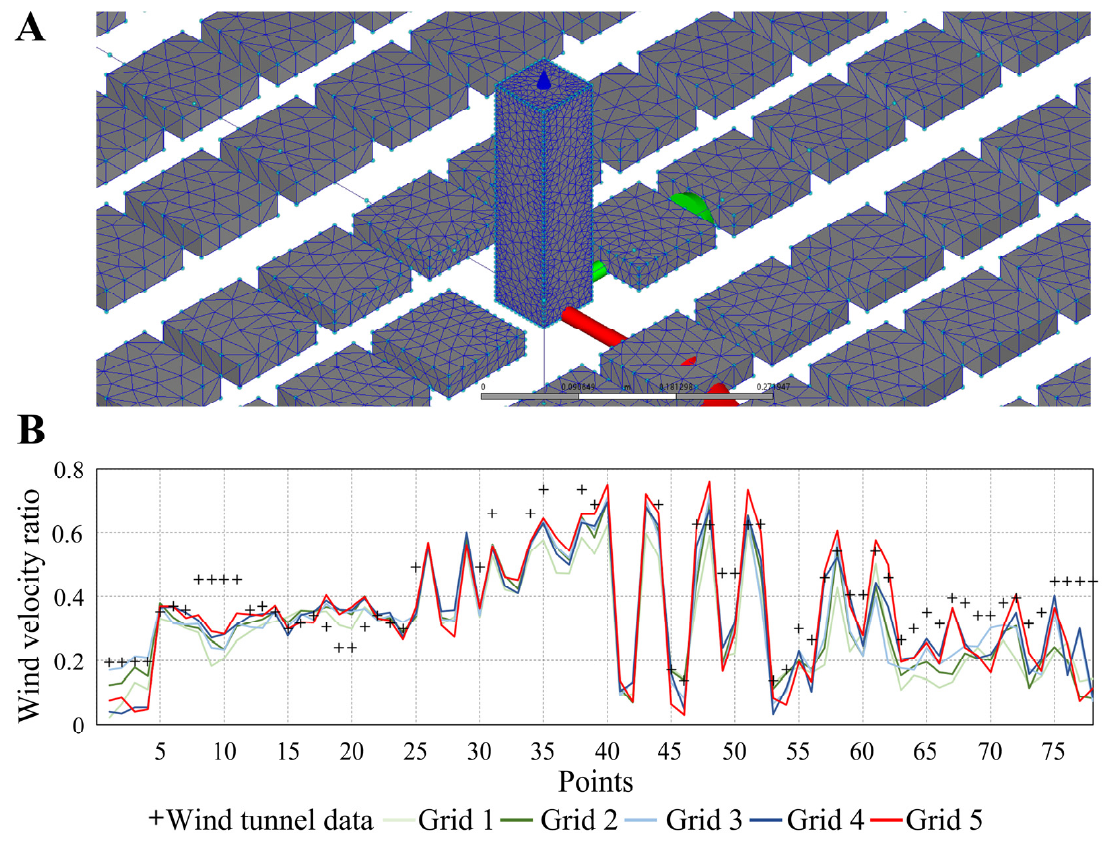
Figure 5. ( A ) Diagram of the grid generated by Autodesk CFD; ( B ) comparison of wind velocity ratio at pedestrian level obtained by different grid schemes of Autodesk CFD at 0 ◦ wind direction. Wind velocity ratio is the ratio of simulated wind velocity U to reference velocity U ref (6.65 m/s).